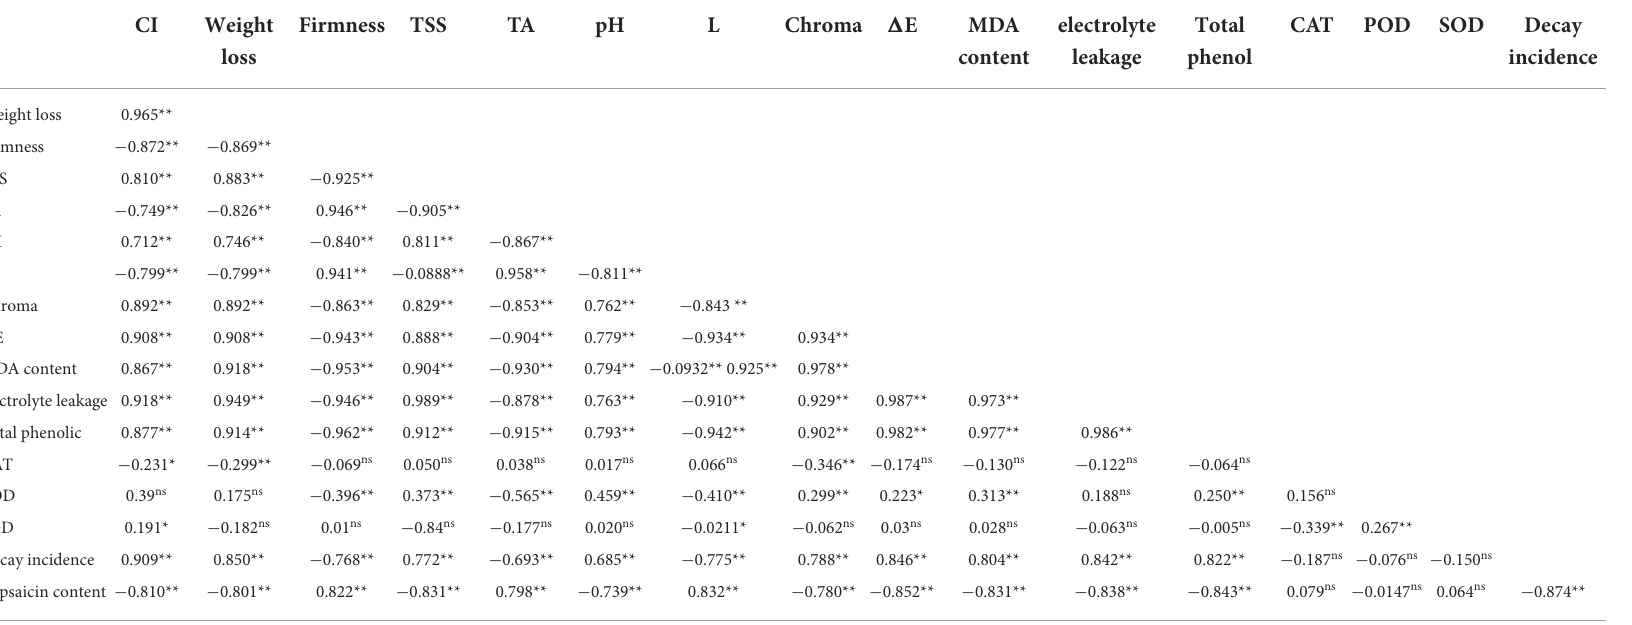
TABLE 2 Pearson correlation matrix for chilling injury and physiological properties (weight loss, firmness, and color), biochemical properties (TSS, TA, pH, MDA content, membrane leakage, total phenol, and capsaicin content), decay incidence, and antioxidant enzymes activity (CAT, POD, and SOD) in Sweet pepper fruit treated with foliar spraying of SA and caraway oil-coating after 60 d of storage period at 4 ± 2 ◦